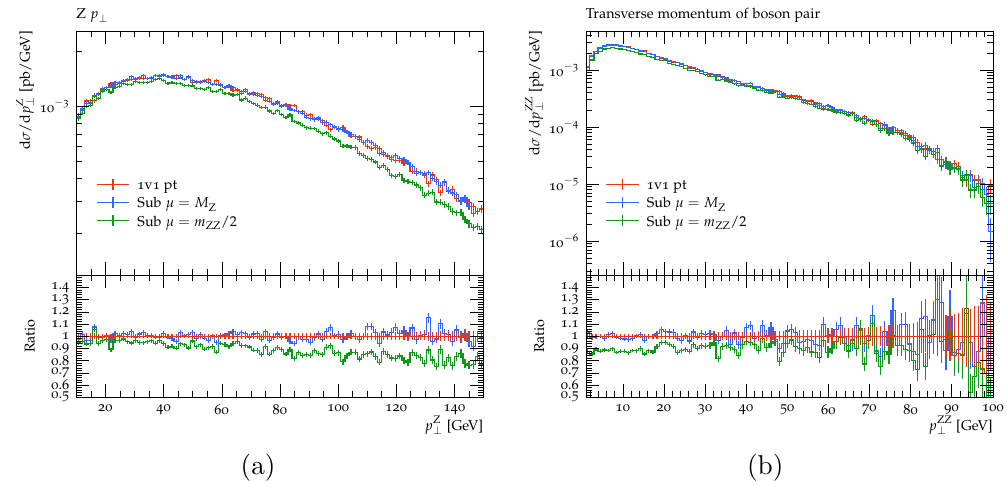
Figure 7 . (a) Transverse momenta of the Z 0 bosons and (b) transverse momentum of the Z 0 Z 0 pair for di(cid:11)erent values of the scale (cid:22) used in equation (3.28). The momentum fractions X are set to be equal to the pre-kick fractions. The 1v1,pt setup is the reference in the ratio plots. The histograms are not normalised to